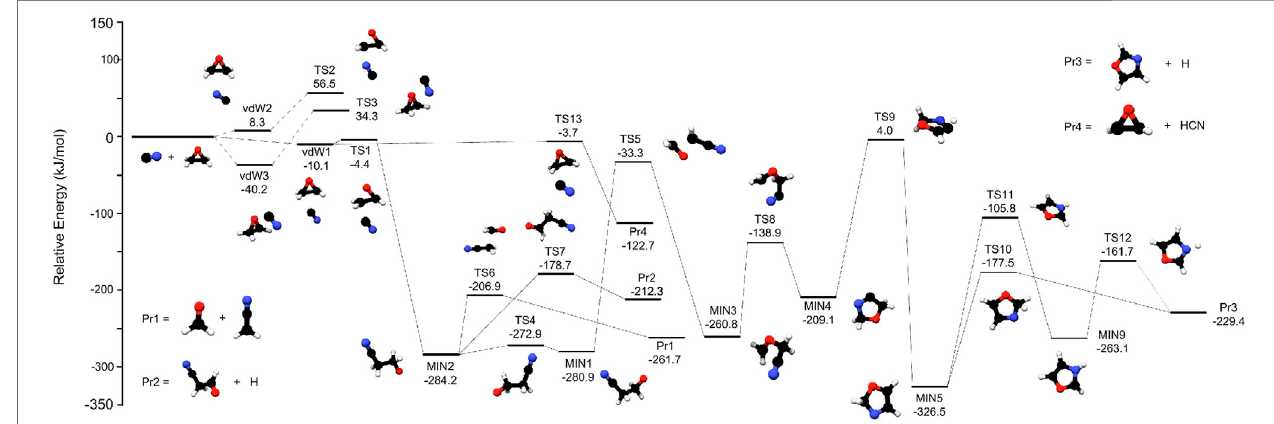
FIGURE1| ThemostrelevantstationarypointslocatedonthePESforthereactionbetween c -C 2 H 4 OandCN.Energies(inkJ mol − 1 )aregivenwiththerespecttothereactants.